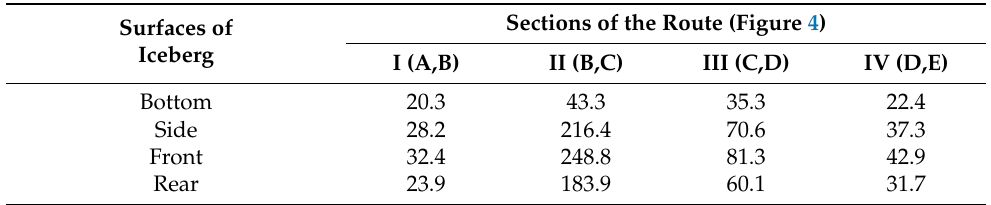
Table 5. Calculated and assumed average values of the heat transfer coefficient α on the respective walls of the underwater part of the iceberg, W/m 2 K (own elaboration).